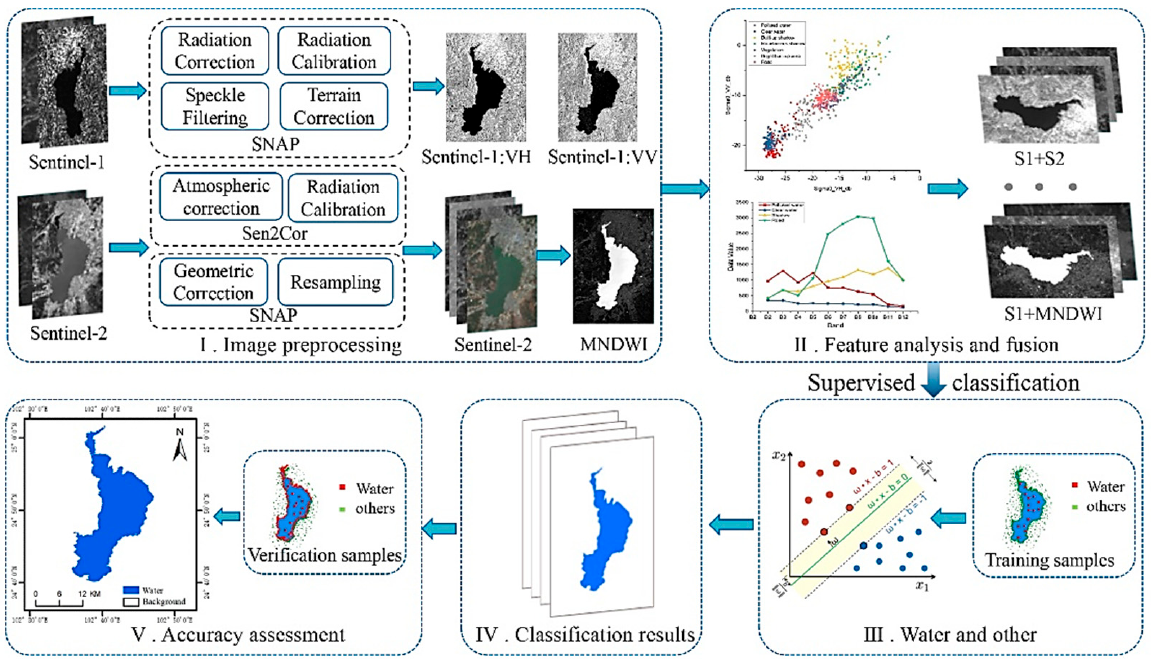
Figure 2. Conceptual workflow of the proposed data fusion method.